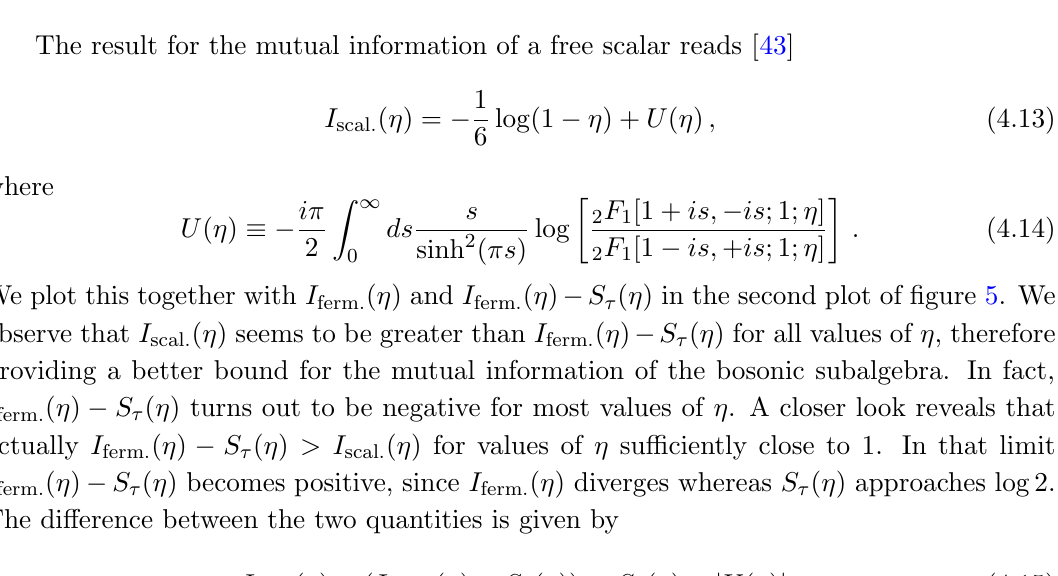
Figure 6 . We plot j U ( (cid:17) ) j and S (cid:28) ( (cid:17) ) for values of the cross ratio close to 1. S (cid:28) ( (cid:17) ) becomes smaller than j U ( (cid:17) ) j as we approach that limit, implying that I ferm : ( (cid:17) ) (cid:0) S (cid:28) ( (cid:17) ) provides a better bound than I scal : ( (cid:17) ) to the bosonic subalgebra mutual information near (cid:17) =